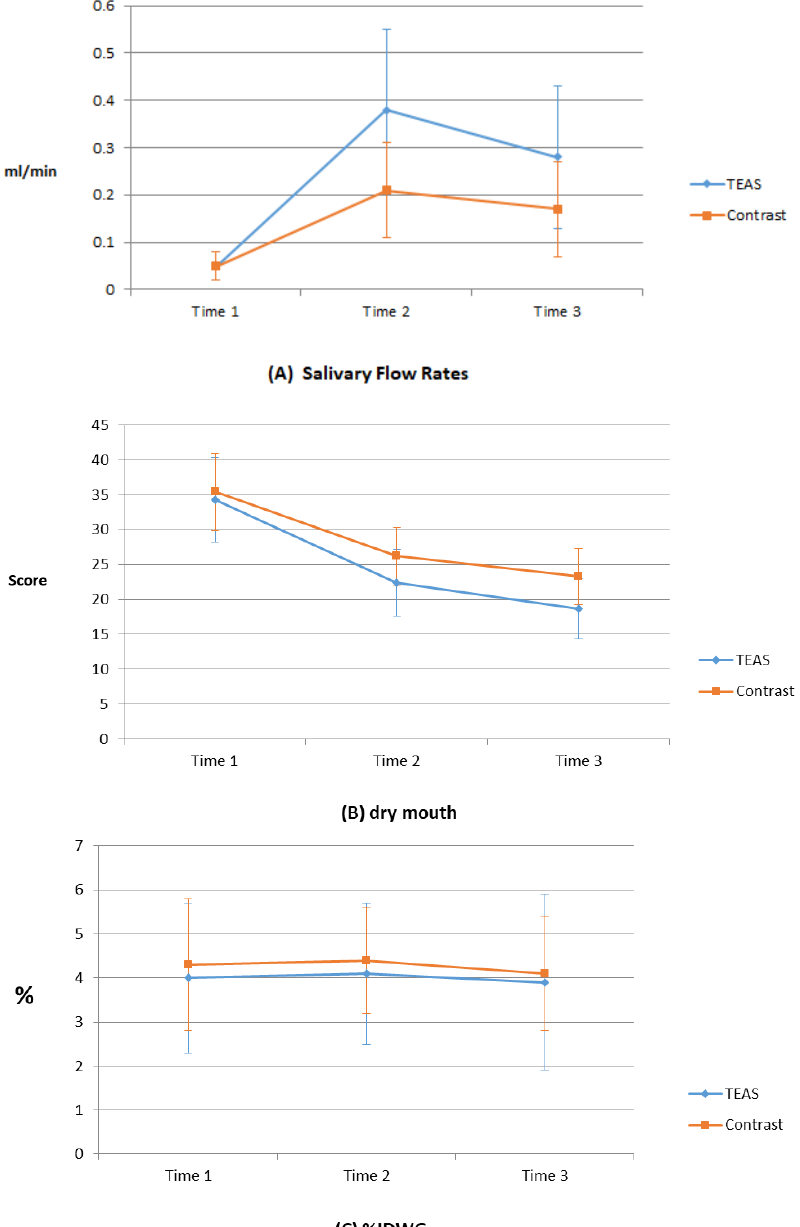
Figure 2. Effect of a TEAS program on saliva flow rate, dry mouth, and %IDWG: ( A ) saliva flow rates, ( B ) dry mouth, and ( C ) %IDWG. Time 1: before program; time 2: immediately post-program; and time 3: 1 week after program. Table 3. Effect of electrical stimulation of acupoints for %IDWG ( n = 11).